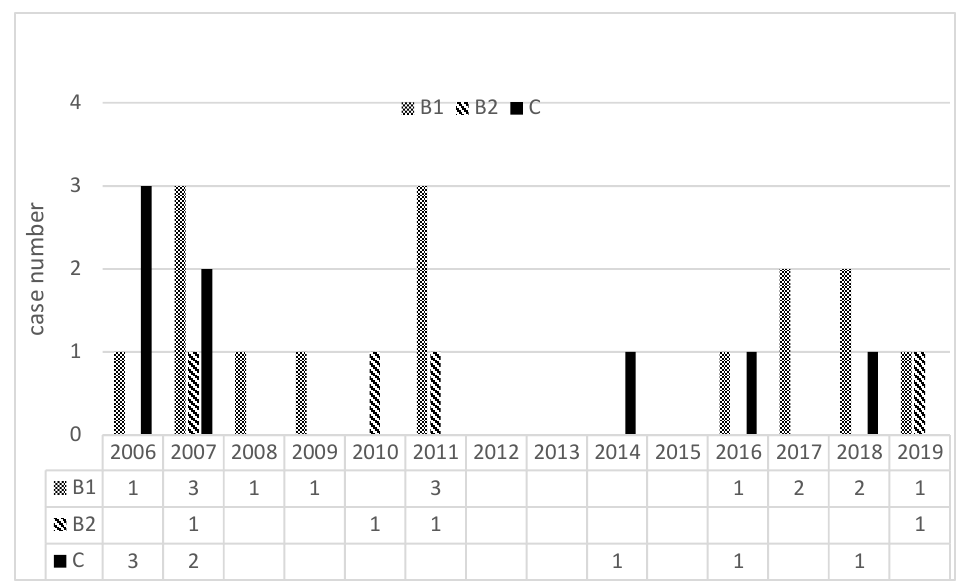
Figure 2. The number of cases for a specific treatment plan, shown according to the year in which the patient received the surgery and angiography.